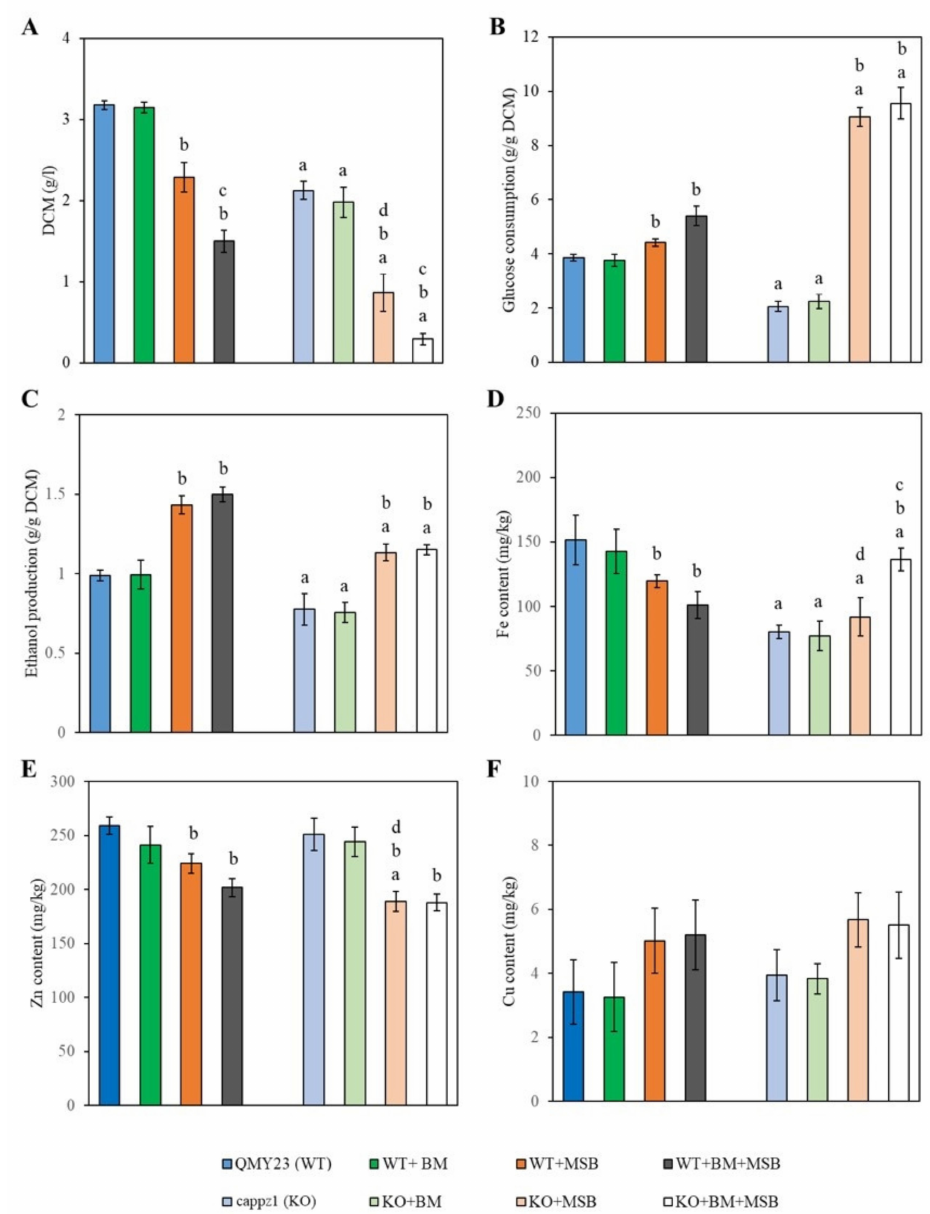
Figure 4. The physiological effects of C. albicans protein phosphatase Z1 ( CaPPZ1 ) gene deletion, betamethasone (BM) pre-treatment and/or menadione sodium bisulfite (MSB) on the growth ( A ), glucose utilization ( B ), ethanol production ( C ) and metal content ( D – F ) of the QMY23 (WT) or cappz1 mutant (KO) C. albicans strains. Cell cultures were supplemented with 2 mM BM at 0 h incubation time and oxidative stress (+1.5 mM MSB) was initiated at 4 h incubation time. Samples were taken after 4 h of MSB exposure. Data represent mean values ± SD calculated from 3 independent experiments. a Significant difference between untreated KO vs. untreated WT and treated KO vs. treated WT. b Significant difference between treated WT vs. untreated WT and treated KO vs. untreated KO. c Significant interaction between the effects of BM and MSB according to two-way ANOVA in the studied strain. d Significant interaction between the effects of MSB and the deletion of CaPPZ1 according to two-way ANOVA (BM pre-treated cultures were omitted from the